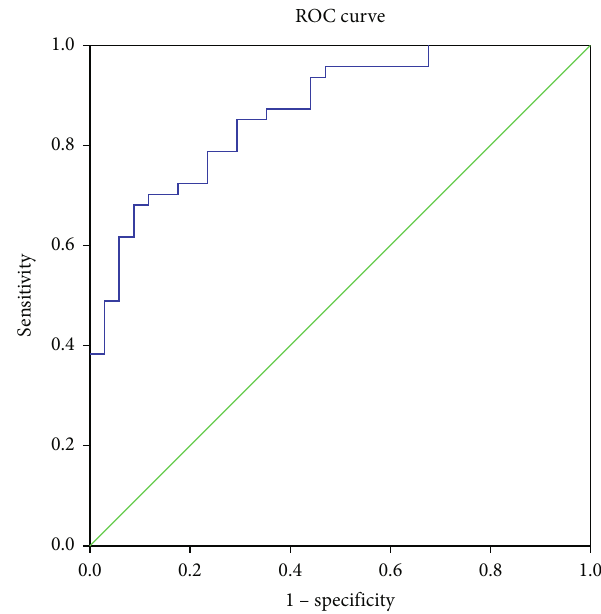
Figure 1: ROC curve analysis of SII values in the patients with active ulcerative